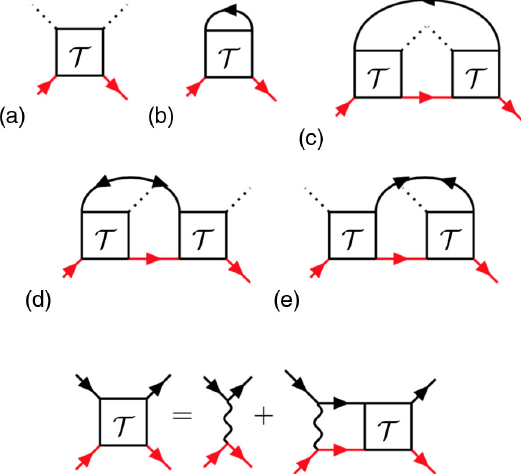
FIG. 6. (Top panel) Diagrams for the self-energy for a general boson-impurity interaction strength. (Bottom panel) Ladder approximation for the boson-impurity scattering matrix T ð p Þ .